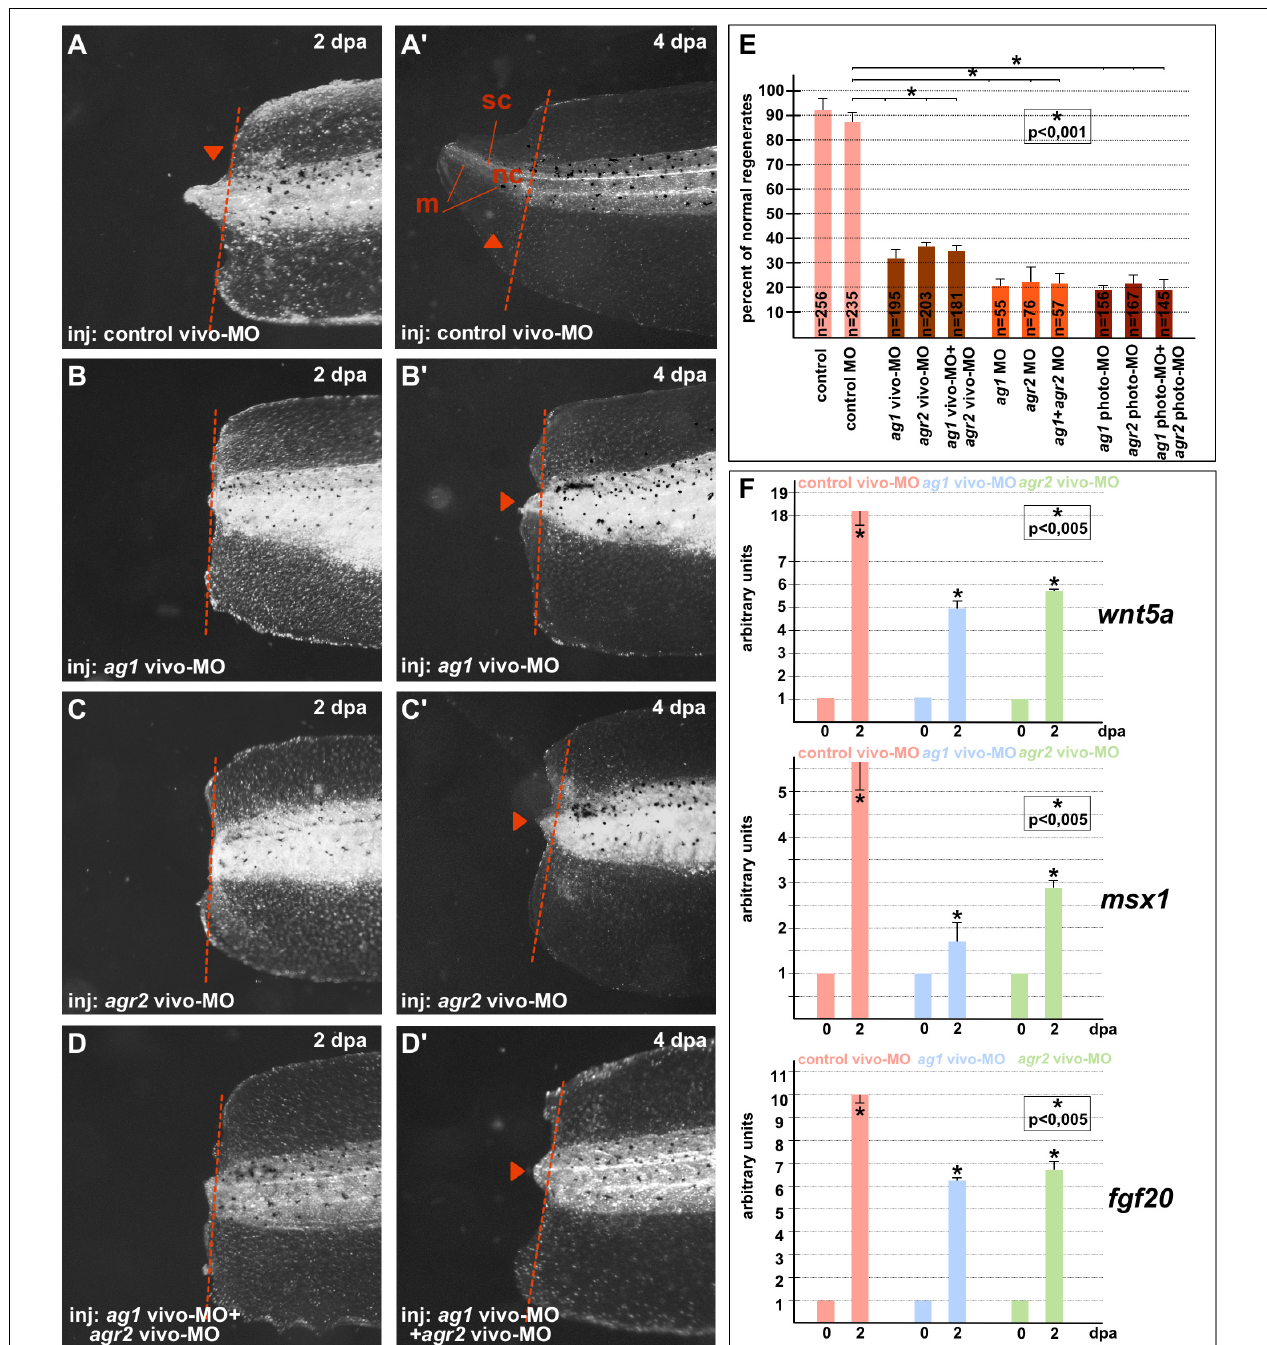
FIGURE 1 | Downregulation of ag1and/or agr2 genes leads to regeneration blockage. (A,A’) Imaging of Xenopus laevis tadpoles developed from embryos injected with control morpholino oligonucleotides (control MO) and regenerating tail tip at two developmental timepoints corresponding to 2 and 4 days post amputation (dpa). Lateral view, dorsal to the top. Dashed red line indicates amputation level. Sc, spinal cord; nt, neural tube; m, muscles. Tail tip regeneration is dramatically reduced if ag1 and/or agr2 genes are downregulated by injection of embryos with ag1 vivo-MO (B,B’) , agr2 vivo-MO (C,C’) , or both (D,D’) . (E) Quantification of normal regenerates percentage among controls and ag1/agr2 morphants. N—number of tails analyzed. Error bars indicate SD. Statistical significance was determined with t -test for independent samples; the results are statistically significant, p < 0.001 (asterisk). (F) qRT-PCR analysis of expression levels changes of regeneration markers wnt5a, msx1 and fgf20 during the regeneration process (at 0 and 2 dpa) in amputated tails of tadpoles injected with control , ag1 and/or agr2 vivo-MO . The value of normalized PCR signal in the 0 dpa sample, harvested immediately after amputation, was taken as an arbitrary unit in each series. Dpa—days post amputation. Error bars indicate SD, t -test, p < 0.05 (asterisk).